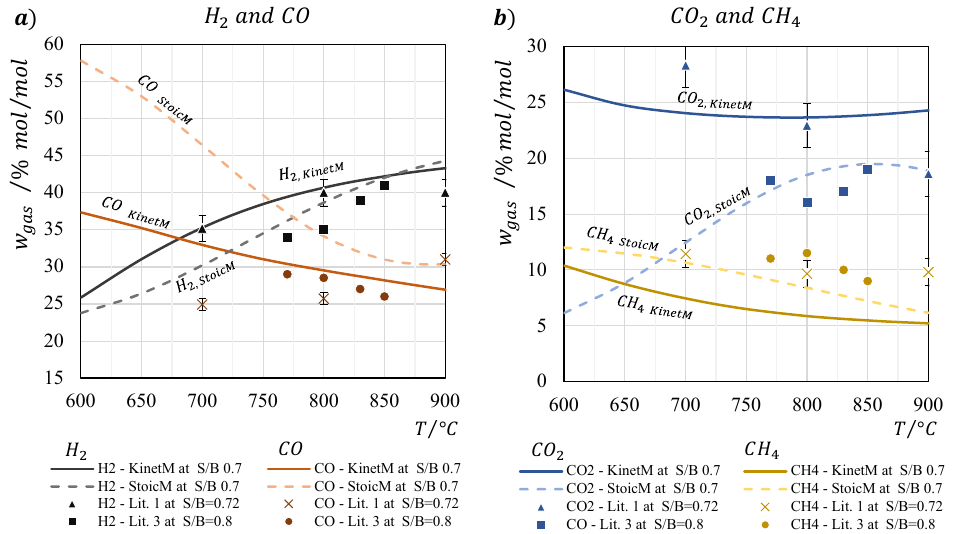
Figure 4. Effect of T on the dry syngas at S / B = 0.7, comparing KinetM (continuous lines) and StoicM (dashed lines) with results of the literature: ( a ) H 2 and CO. ( b ) CO 2 and CH 4 . Lit. 1 and Lit. 3 are taken, respectively, from [22,46].